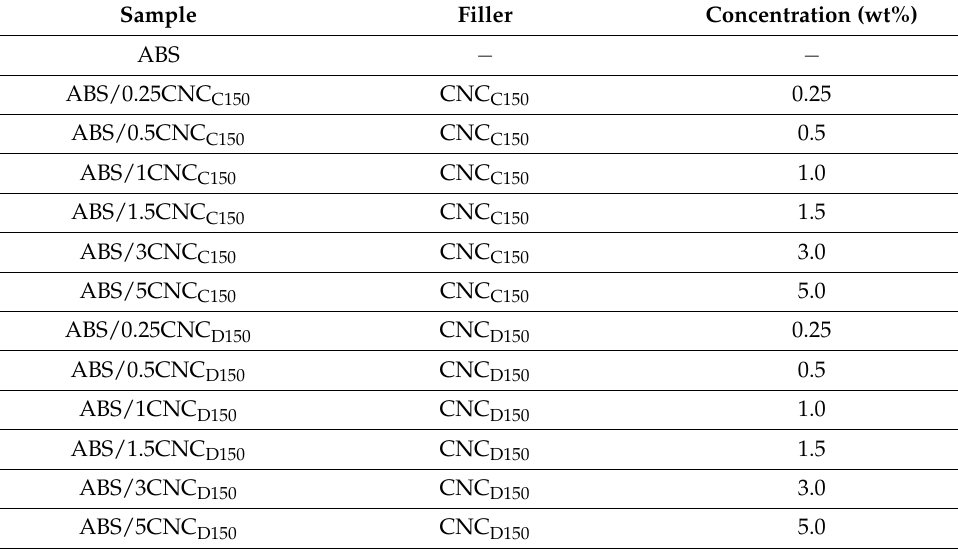
Table 2. Formulation of the ABS